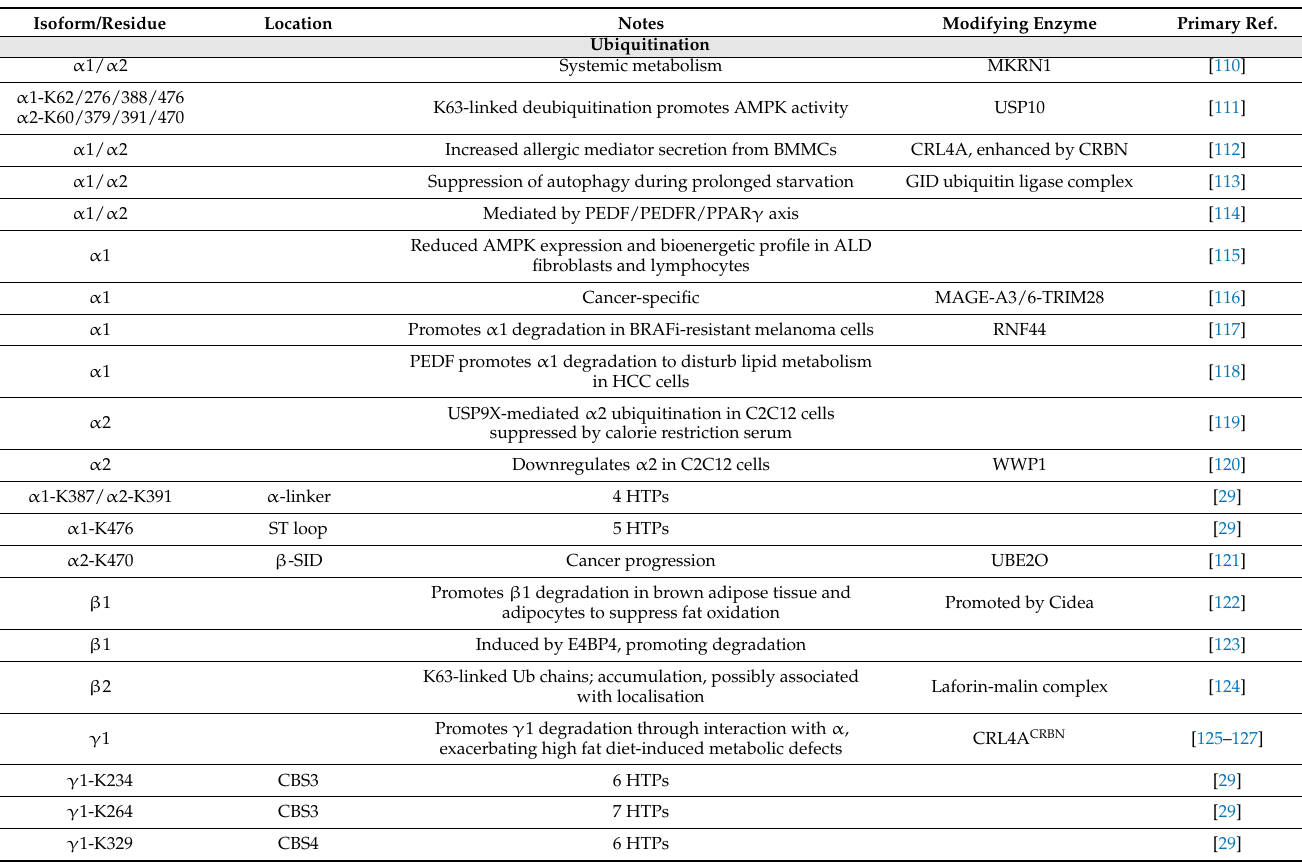
Refer to Table 3 for a summary of reversible, non-phosphorylation PTMs on AMPK. Table 3. Reversible AMPK modifications